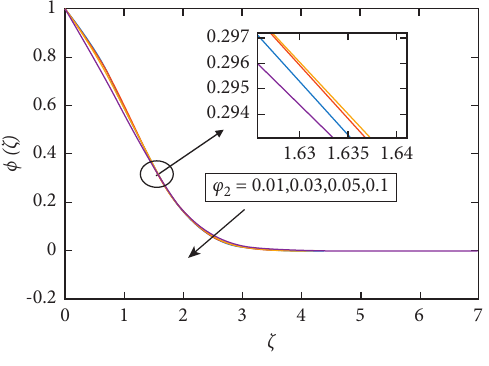
Figure 10: M variation on f ′ ( ζ )